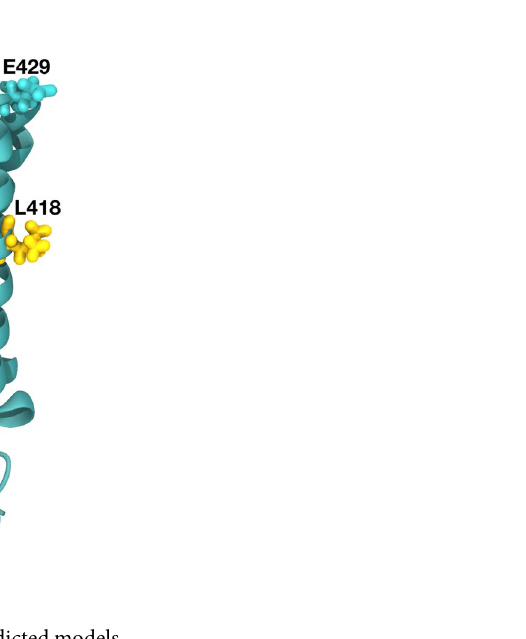
Figure 3. Residue mapping in the SLC22A12 predicted